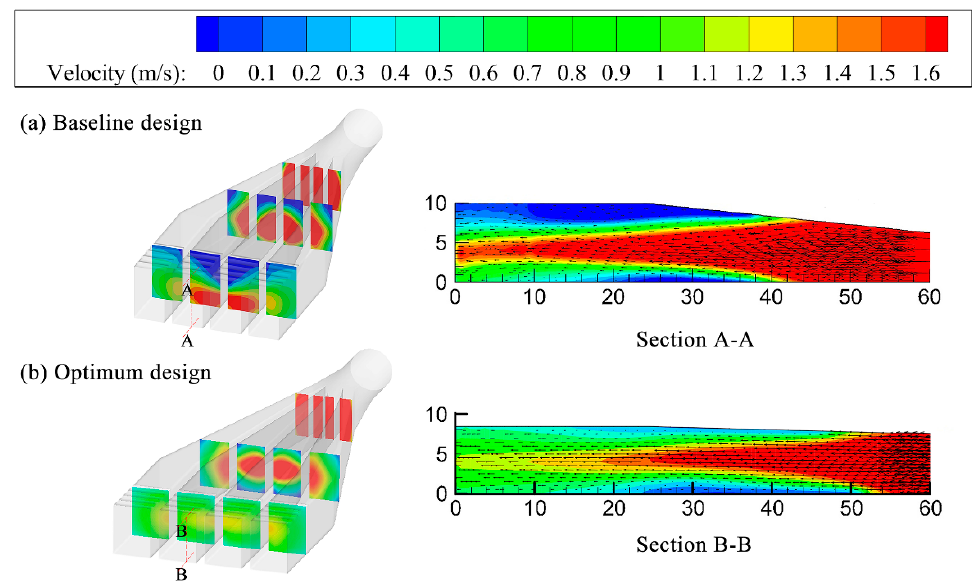
Figure 14. The comparison of outflow velocity distribution between the baseline and optimum design.